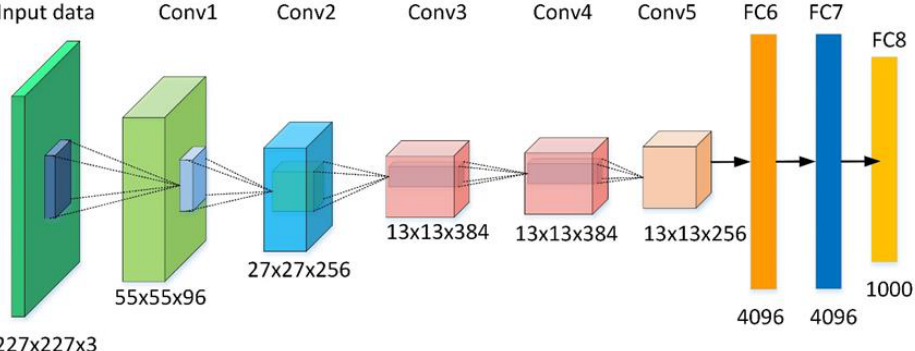
Figure 2. The architecture of